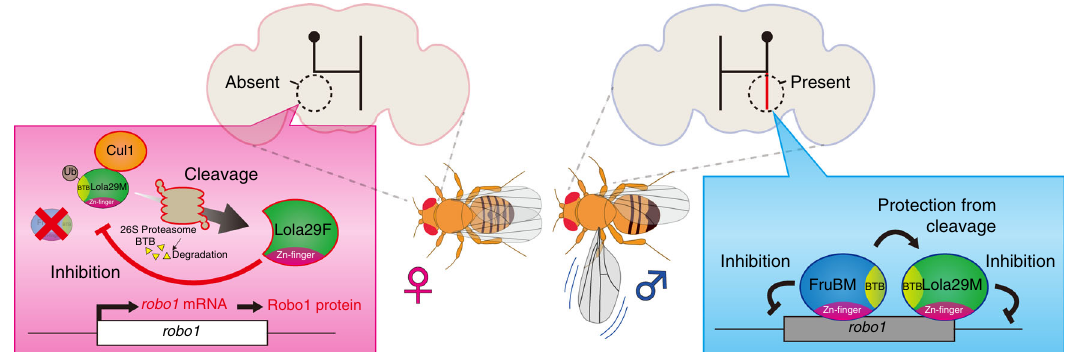
Fig. 7 A model of the interaction between Lola29M and Fru in shaping the sexual dimorphism of mAL neurons and fl y sexual behavior. Female neurons (left-hand side) lack FruBM, and consequently Lola29F is produced in suf fi cient abundance to impede the masculinizing action of Lola29M, leading to the production of mAL neurons without the ipsilateral neurite. Male neurons (right-hand side) express FruBM, which forms a complex with Lola29M and represses proteolysis of Lola29M. This results in the accumulation of Lola29M, which induces the ipsilateral neurite in some mAL neurons via